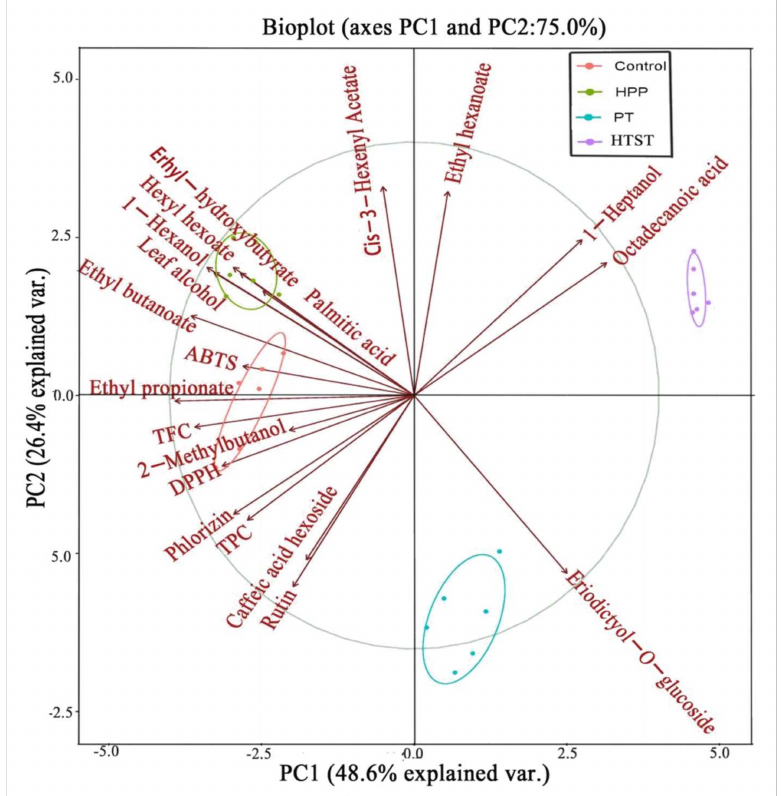
Figure 3. Principal component analysis (PCA) plot of the taste and related attributes, color and related attributes, aroma compounds, antioxidants and antioxidant capacity attributes in control, high- pressure processing (HPP), pasteurization (PT), and high-temperature short time (HTST) treatment passion fruit pur é